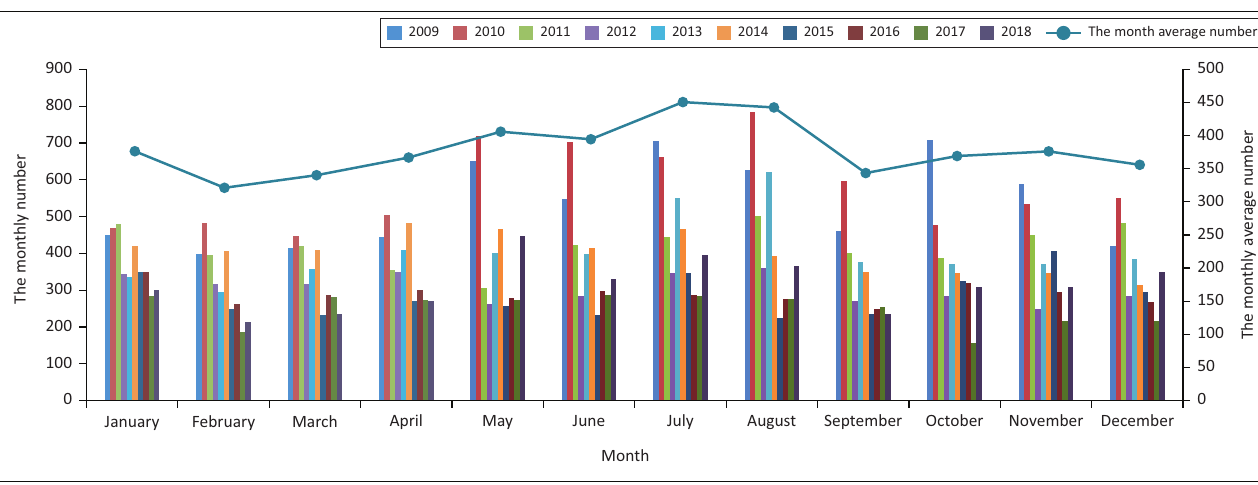
FIGURE 4: Statistics on the number of emergencies in each month in Chinese mainland